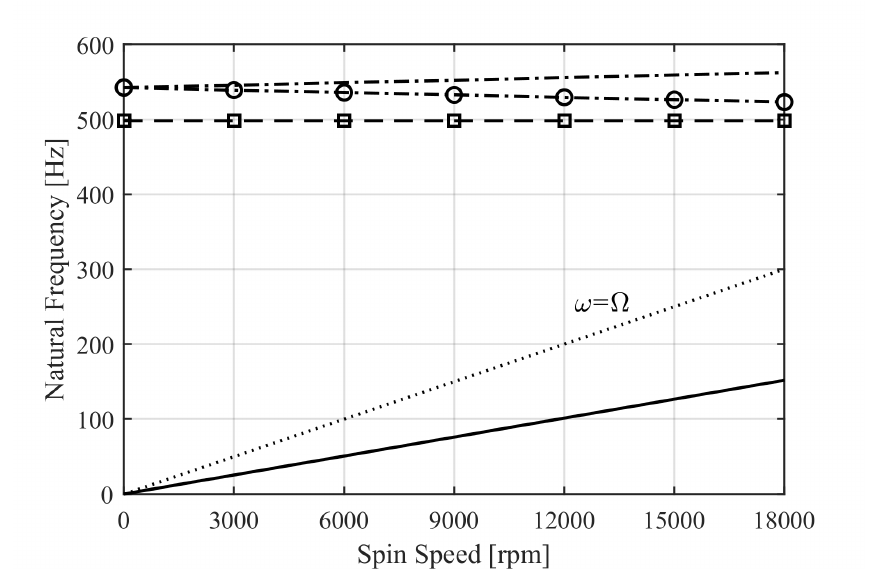
Figure 5. Campbell diagram of the flywheel: conical rigid body mode (solid); forward (dashed with squares) and backward (dashed) pure radial modes; forward (dash-dotted with circles) and backward (dash-dotted) radial shearing modes; synchronous whirling (dotted). The forward and backward pure radial modes (dashed with squares and dashed, respectively) are